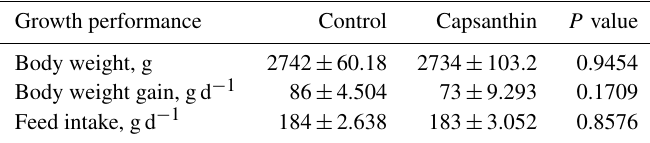
Table 3. Effect of dietary capsanthin supplementation on growth parameters of broiler chickens at 42d of age. Growth performance